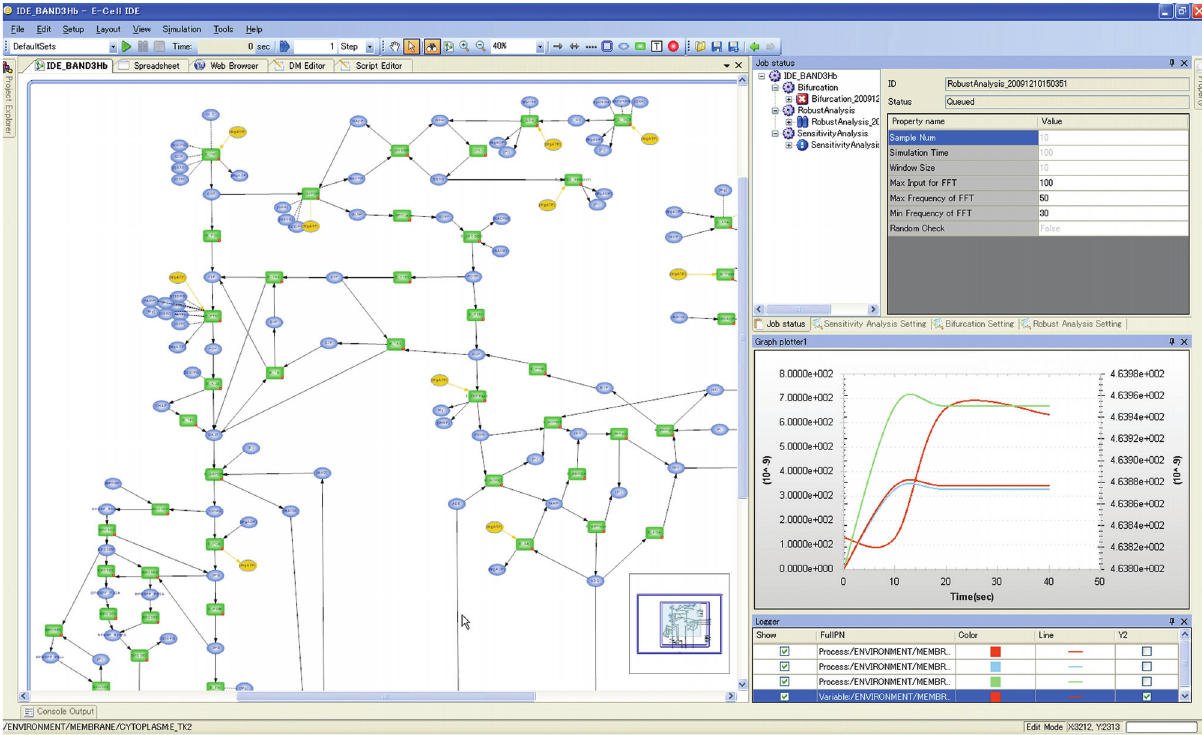
Figure 1: View of the on-screen E-Cell GUI (E-Cell IDE). The E-Cell IDE has a user-friendly pathway editor (left) and a GUI-based mathematical analysis tool kit (right top). The simulated dynamics is visualized in the tracer of the time histories of variables/processes (bottom right), as well as in the pathway map